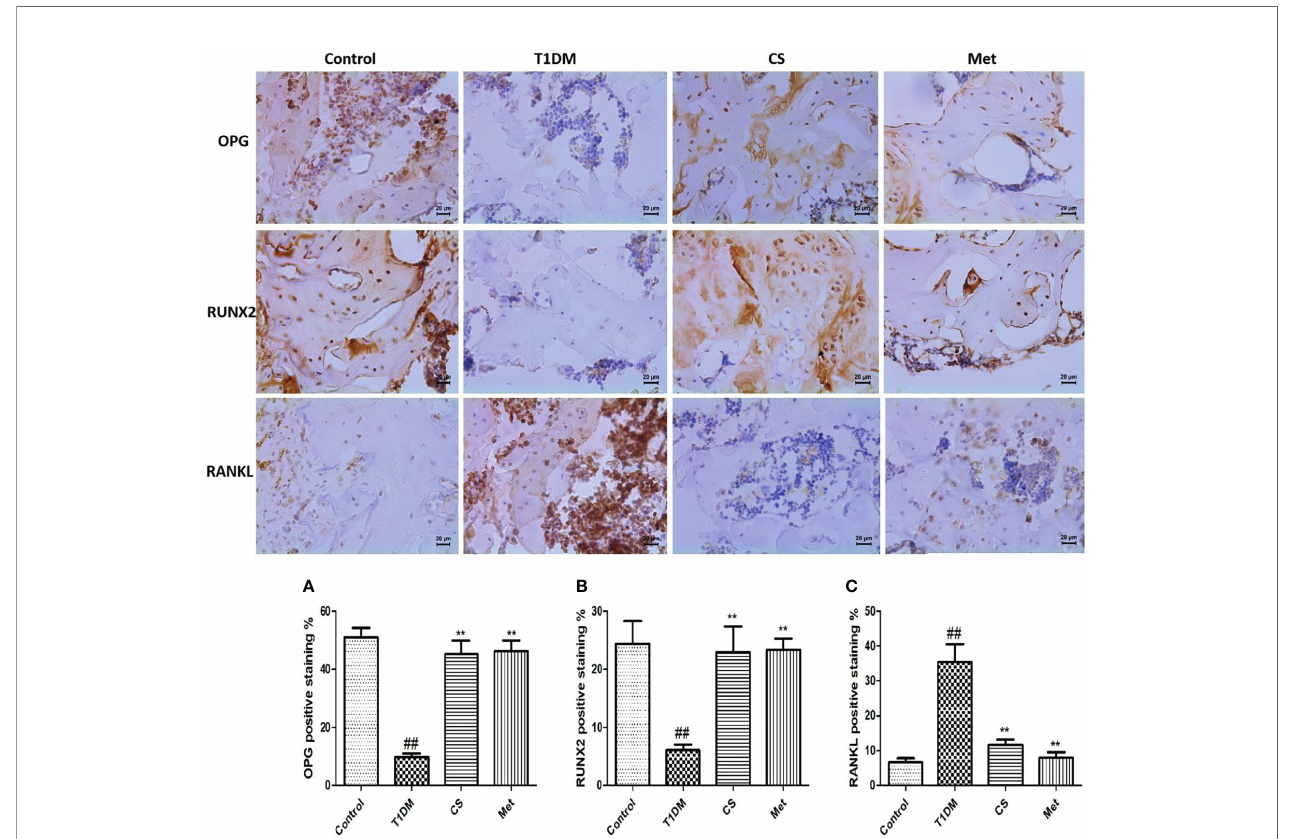
FIGURE 9 | Immunohistochemical staining of femur and positive staining percentage of OPG, RUNX2, and RANKL in each group. (A) The positive staining percentage of OPG in the femur of each group. (B) The positive staining percentage of RUNX 2 in the femur of each group. (C) The positive staining percentage of RANKL in the femur of each group. ## indicates p < 0.01 compared with control. **indicates p < 0.01 compared with the diabetic